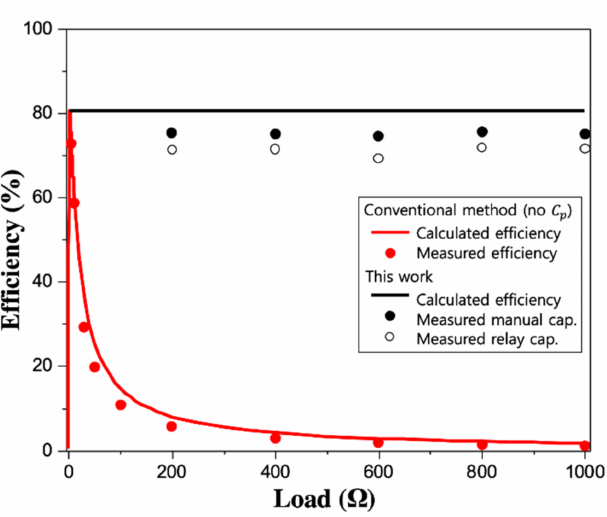
Figure 8. A plot of the transfer efficiency as a function of load. Solid line and the dot represent calculation and measurement, respectively. Note that the solid black dot is measured using manually optimized capacitors and the empty black dot is measured using 4-channel relay capacitor